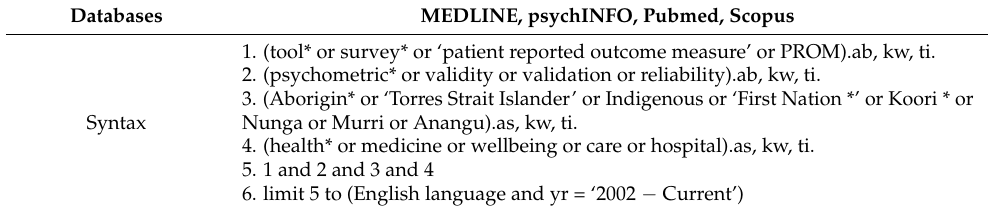
Table 1. Information sources and search syntax.